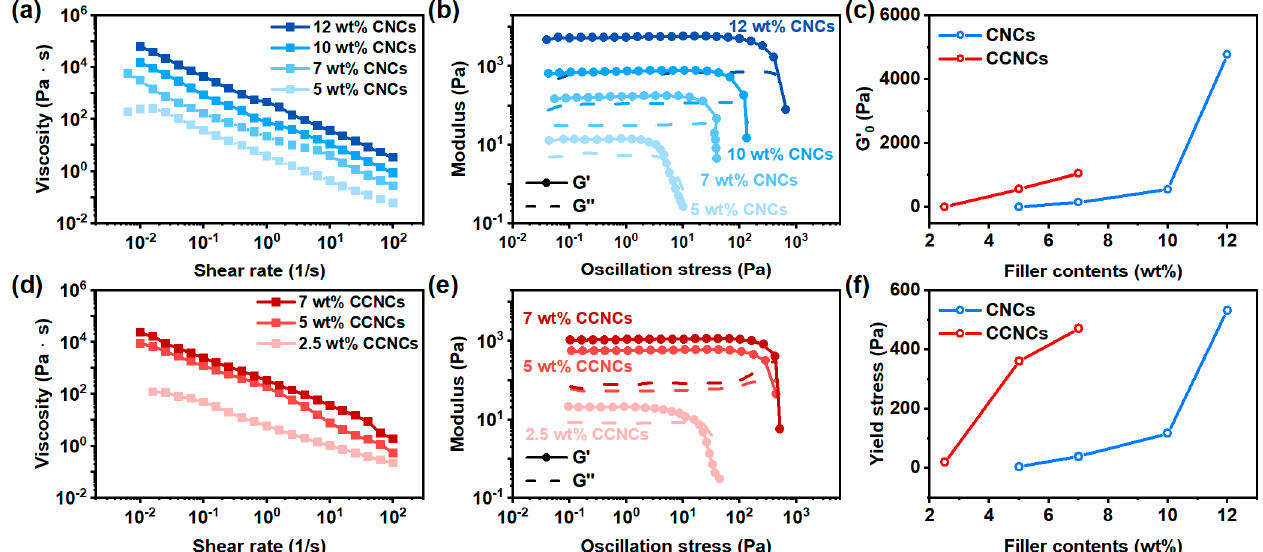
Figure 2. Rheological behavior of the aqueous ink with different concentrations of cellulose nanocrystals (CNCs) and CCNCs. ( a , d ) Steady-state shear viscosity of the ink. ( b , e ) Oscillatory rheological measurement. ( c ) The dependence of initial storage modulus G’ 0 on the concentration of CNCs (blue) and CCNCs (red). ( f ) The dependence of yield stress on the concentration of CNCs (blue) and CCNCs (red).